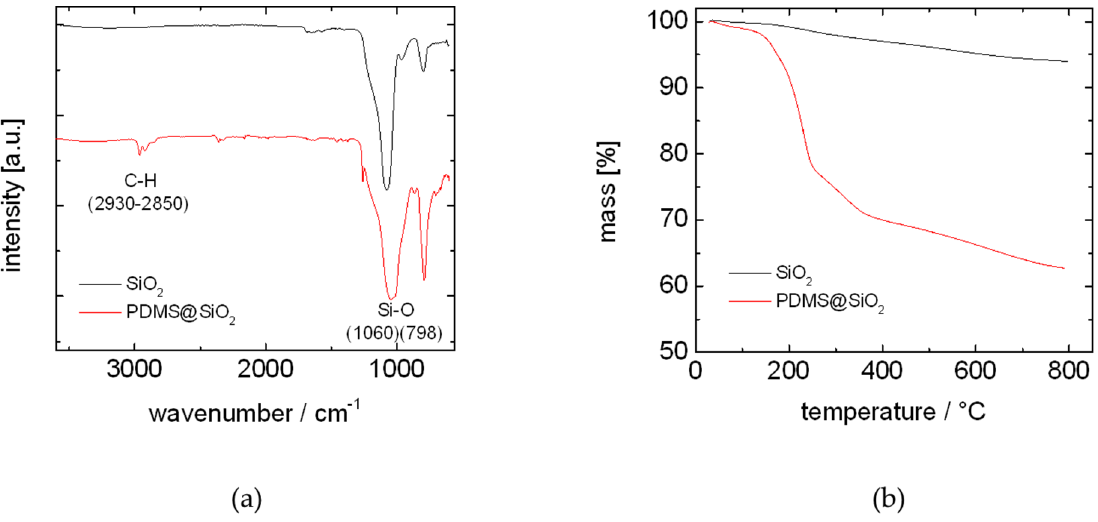
Figure 3. ( a ) ATR–IR spectrum and ( b ) TGA of pure silica particles and PDMS@SiO 2 exemplary shown for the SI–ROP of M 4 with [M 4 ] 0 = 1.49 mol ∙ L − 1 and [B] = 1.49 × 10 − 2 mol ∙ L − 1 .